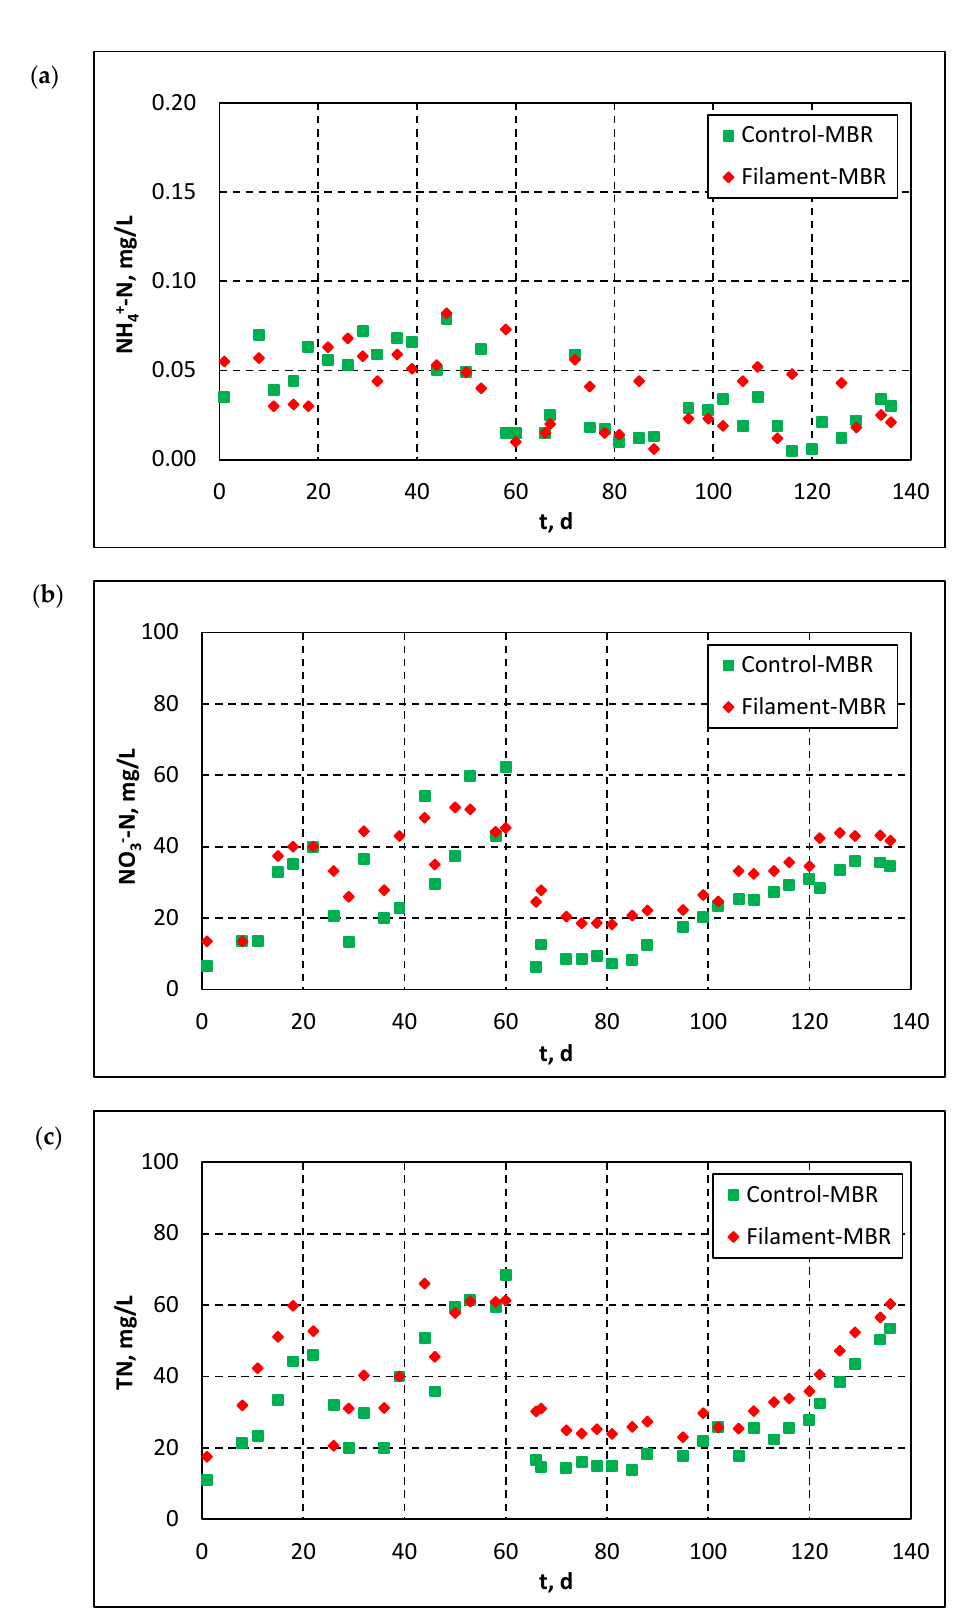
Figure 8. Evolution of concentrations of: ( a ) N-NH 4+ , ( b ) Ν -NO 3 − and ( c ) total nitrogen (TN) in the effluent of both pilot MBRs.